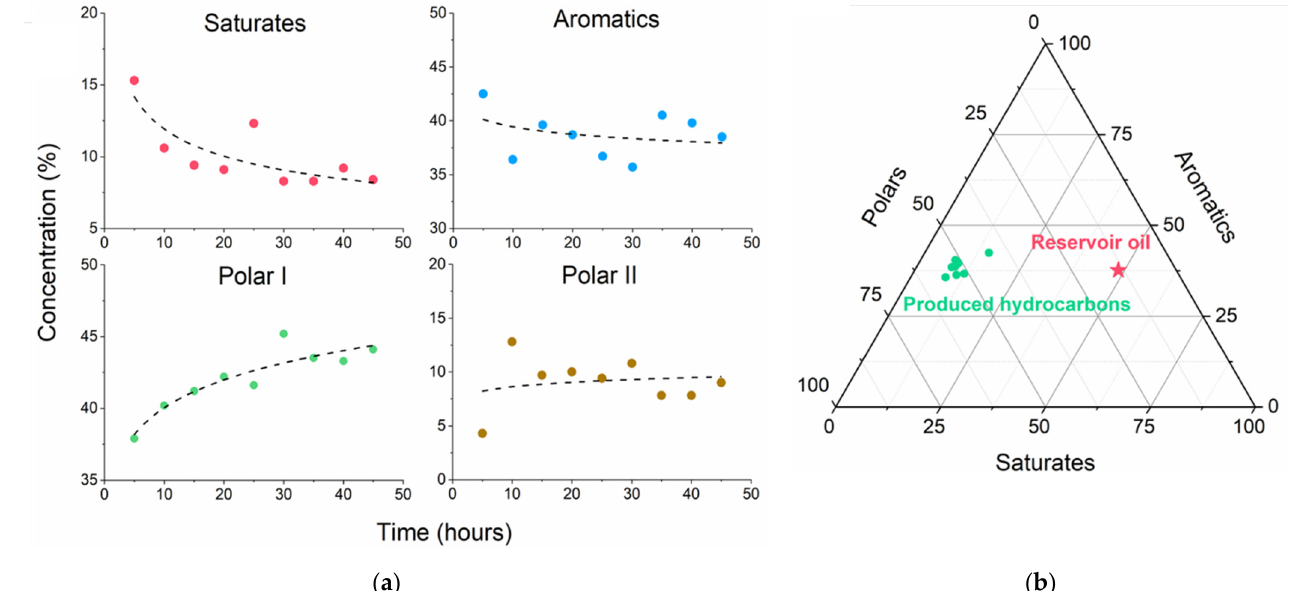
Figure 5. ( a ) SARA composition of the produced liquid hydrocarbons; ( b ) SARA ternary diagram of reservoir oil (red) and produced hydrocarbons (green).